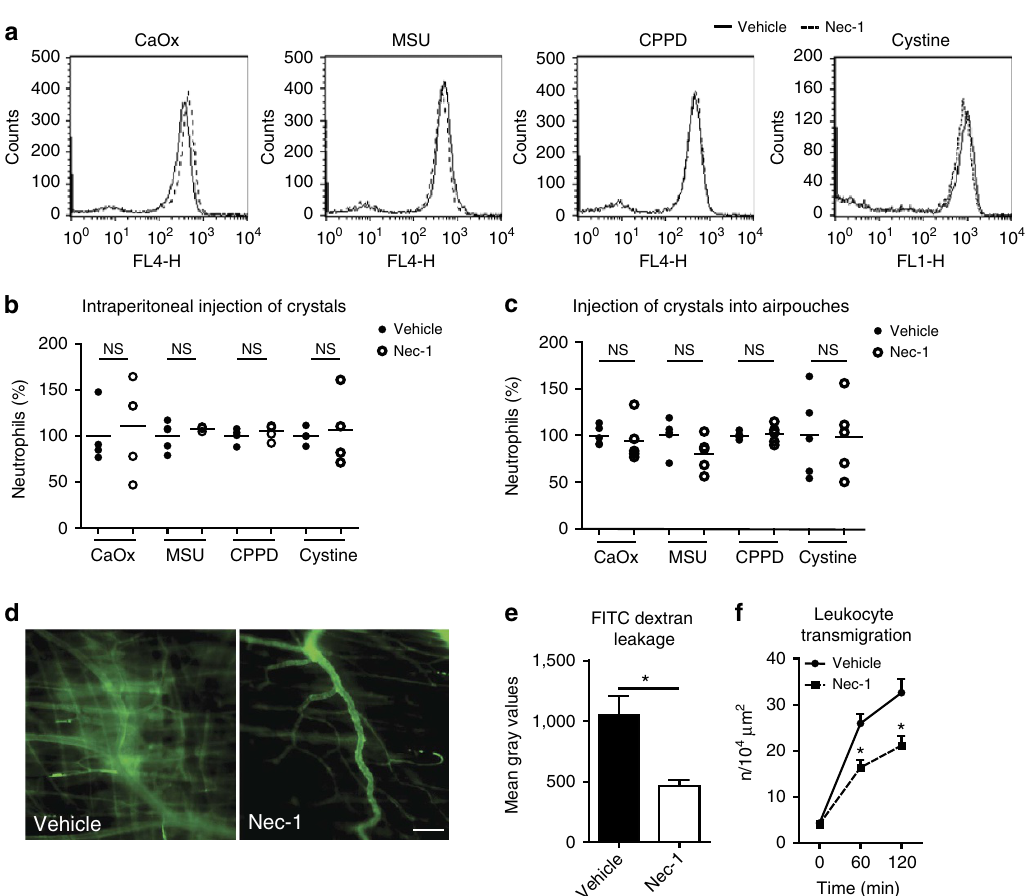
Figure 6 | Necrostatin-1 and neutrophil recruitment. ( a , b ): i.p. injection of CaOx, MSU, CPPD or cystine crystals into C57BL/6 mice ( n ¼ 4 in each group) induces neutrophil recruitment to the peritoneal cavity as determined by flow cytometry of peritoneal lavage fluids. This process is not affected by concomitant necrostatin-1 treatment. A shows representative flow cytometry data for each crystal presented as mean fluorescence intensity for the neutrophil marker. ( b ) Shows data of each mouse with the mean of wild-type mice set as 100%. NS, not significant. ( c ) Similar experiments using the air pouch model of neutrophil recruitment gave identical results ( n ¼ 5 in each group) and are expressed in the same manner. ( d – f ) In vivo microscopy studies of the postischemic musculus cremaster were performed as a second model of injury-associated and ROS-dependent neutrophil recruitment in C57BL/6 mice. Necrostatin-1 significantly reduced the microvascular leakage of FITC-labelled dextran particles as illustrated by representative images in D at an original magnification of (cid:2) 400, scale bar, 100 m m and quantitatively in ( e ). In the same experiment leukocyte transmigration from the microvasculature was quantified by counting from video recordings taken at baseline and at 60 and 120min. Data are means ± s.e.m. from seven mice in each group. Data were analysed using